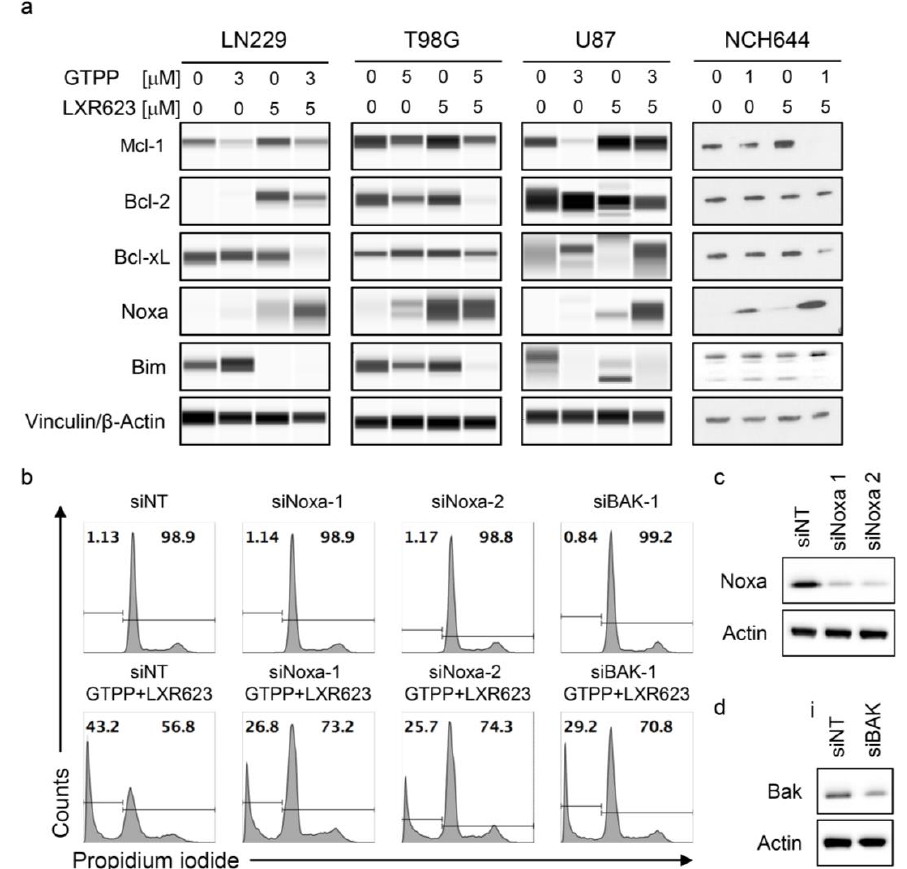
Figure 4. Gamitrinib and LXR623 regulate the expression of Bcl-2 family of proteins . ( a ) LN229, T98G,